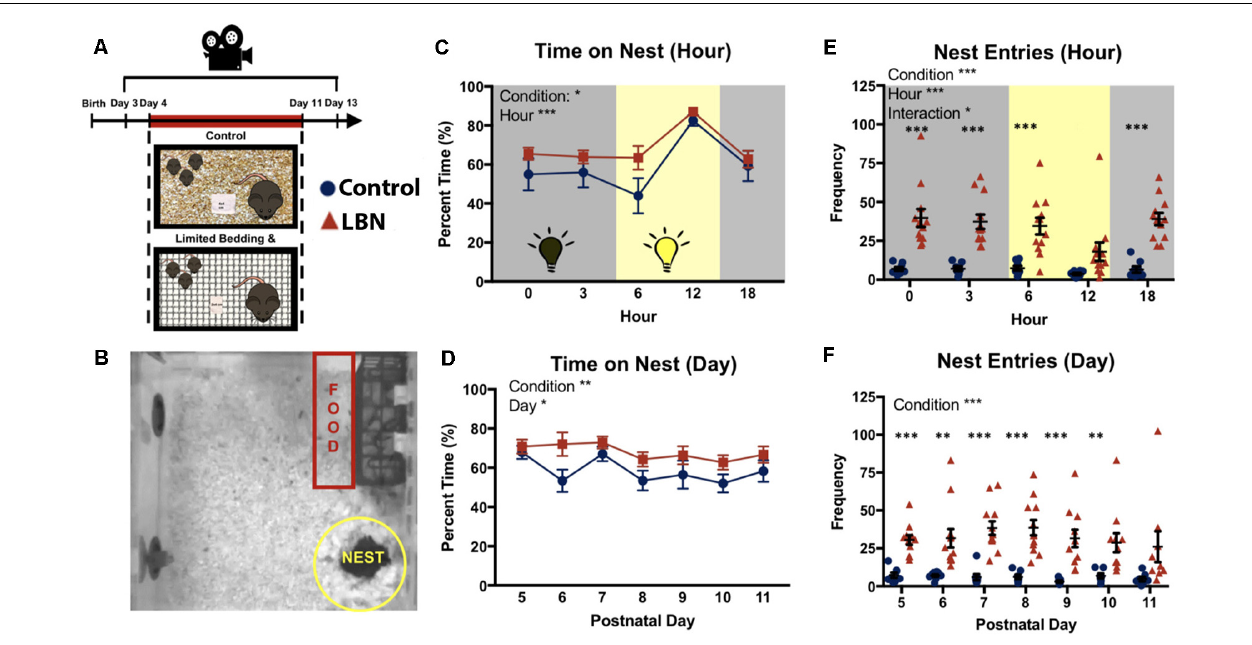
FIGURE 1 | Effects of limited bedding and nesting (LBN) on nesting behaviors of dams. (A) Experimental timeline and setup. (B) Representative map of mouse home cage demarcating locations and size of nest and food zones. (C) Time spent on nest significantly differed by condition ( F ( 1,18.0 ) = 7.70, p = 0.01) and hour ( F ( 4,21.8 ) = 23.7, p = 1.16 × 10 − 7 ). (D) LBN dams spend significant more time on nest across days. Significant effects of condition were found at P6 ( t ( 17.5 ) = 2.24, p = 0.038) and trending at P10 ( t ( 13.0 ) = 1.81, p = 0.093). (E) Over the circadian cycle (dark = gray; light = yellow), a significant effect of condition ( F ( 1,17.8 ) = 29.67, p = 3.7 × 10 − 5 ), hour ( F ( 4,570.8 ) = 5.94, p = 1.1 × 10 − 4 ) and condition × hour interaction ( F ( 4,570.8 ) = 2.91, p = 0.02) were found for frequency of nest entries. (F) Across the 7 days of the manipulation, frequency of nest entries differed by condition ( F ( 1,17.40 ) = 29.73, p = 3.97 × 10 − 5 ), but did not significantly differ by